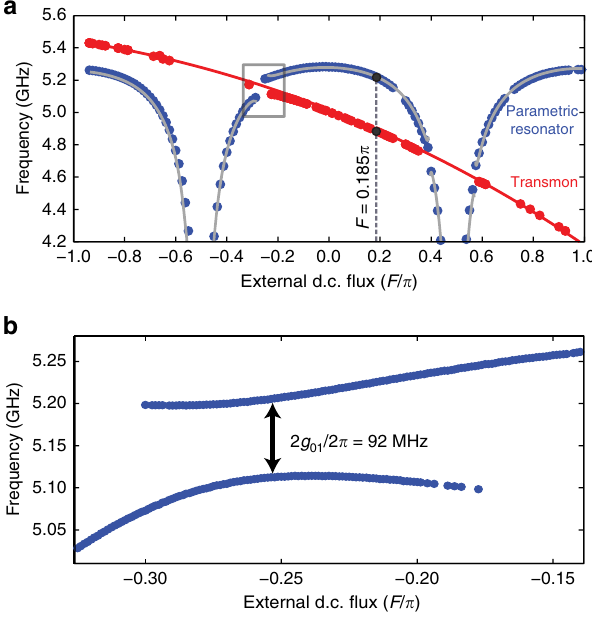
Figure 2 | Combined resonator-qubit frequency spectra. ( a ) Qubit spectroscopy was used to map out the transmon spectrum (in red), whereas the resonator spectrum (in blue) was extracted using standard reflectometry. The solid red and grey lines are fits. The dashed grey line, at resonator flux bias F ¼ 0.185 p , indicates the bias point at which we later demonstrate the read-out method. ( b ) Vacuum Rabi splitting around the flux bias point where the transmon frequency crosses that of the resonator, indicated by the grey box in a . The minimum frequency splitting yields a qubit–resonator coupling g 01 /2 p ¼ 46MHz.